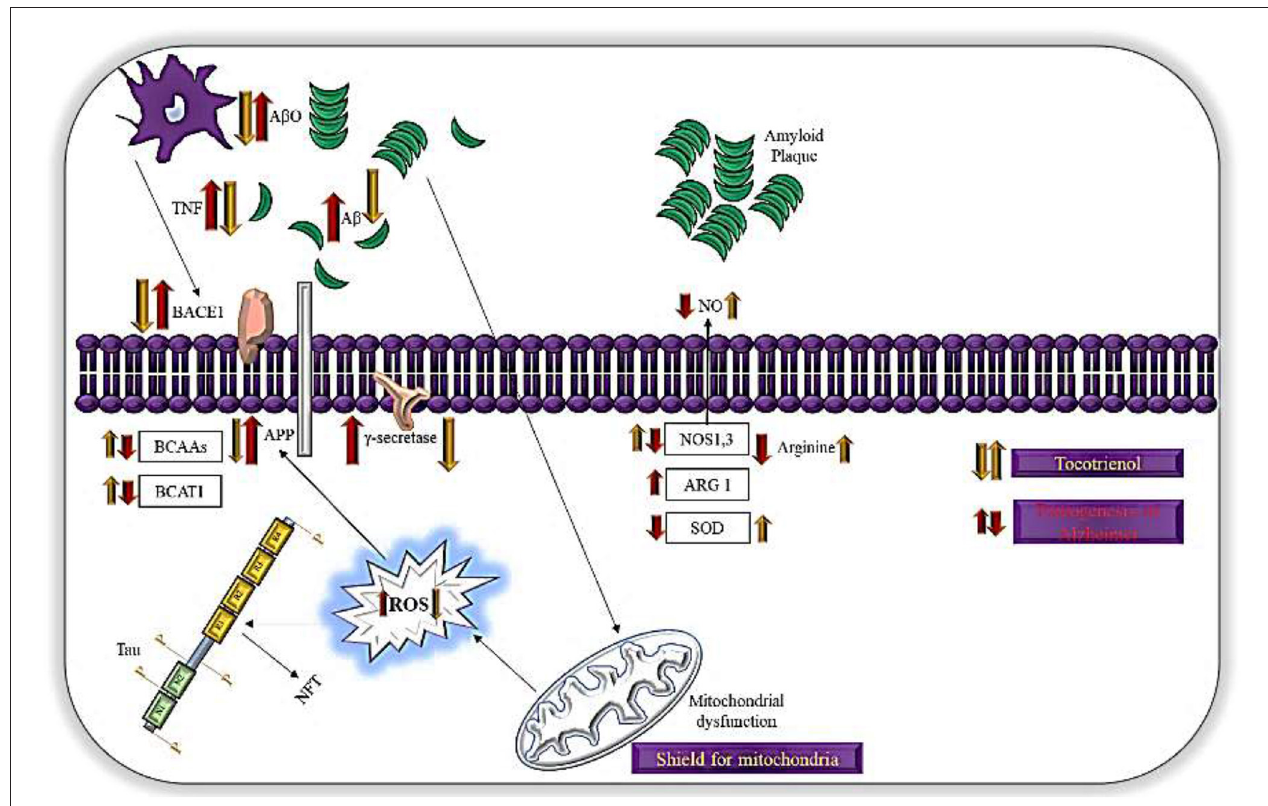
FIGURE 2 | Mechanisms of action of T3s in AD. T3possess antioxidant activities, which mitigate oxidative damage in neurons. T3 shown to increase the translocation of BACE1 to the cellular membrane leading to enhanced non-amyloidogenic APP processing and impaired γ -secretase dependent APP cleavage. This